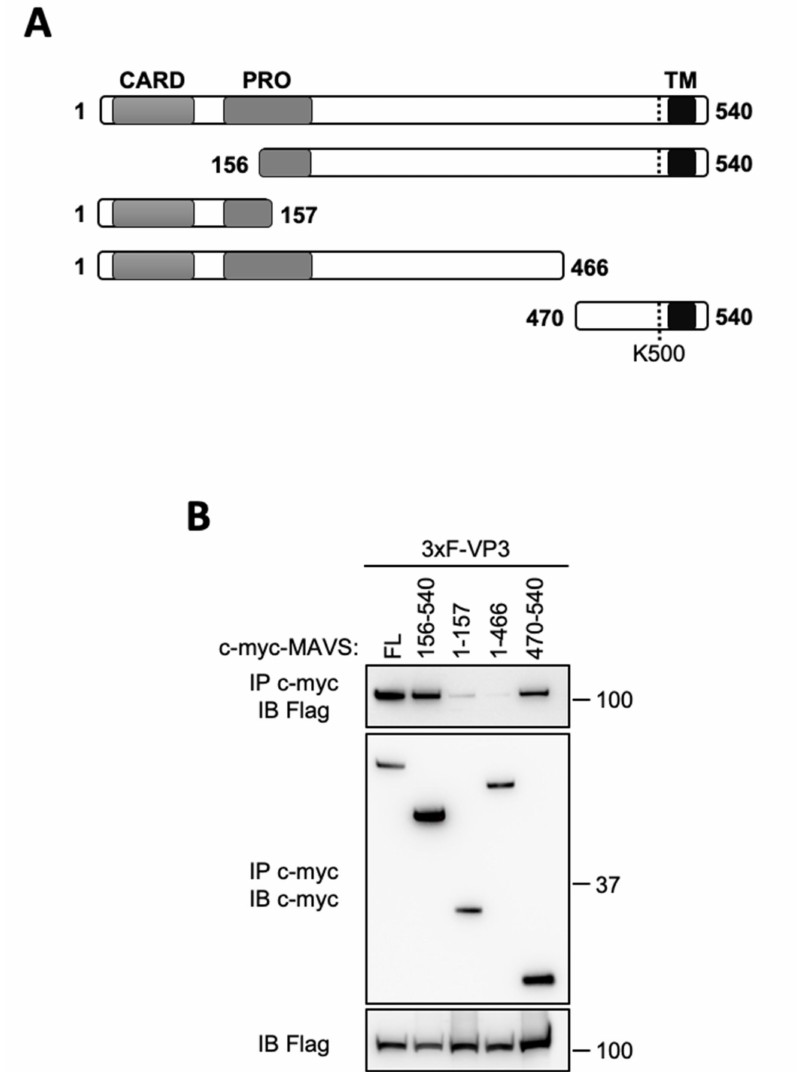
Figure 4. VP3 interacts with the C-terminal domain of MAVS. ( A ) Schematic representation of MAVS protein. The CARD domain (a.a. 1–77), the proline-rich region (PRO) (a.a. 103–173), the transmembrane domain (TM) (a.a. 514–535) and K500 residue are depicted. ( B ) HEK293T were transfected with a vector encoding 3xFlag-tagged BTV-VP3 in the presence of different c-Myc-MAVS constructs as indicated. 24 h after transfection, the cell lysates were immunoprecipitated (IP) with anti c-Myc antibody. The immunoprecipitate and the cell lysate were resolved on SDS–PAGE and immunoblotted with anti 3xFlag and anti c-Myc